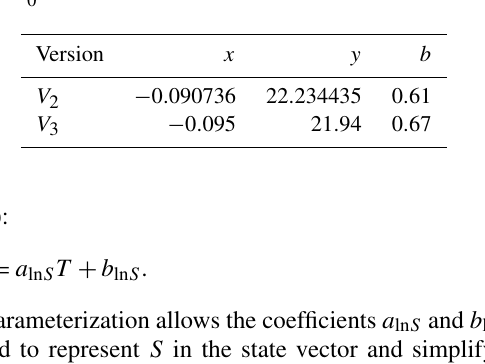
Table 2. Coefficients used in the parameterization of the a priori value of N (cid:48) 0